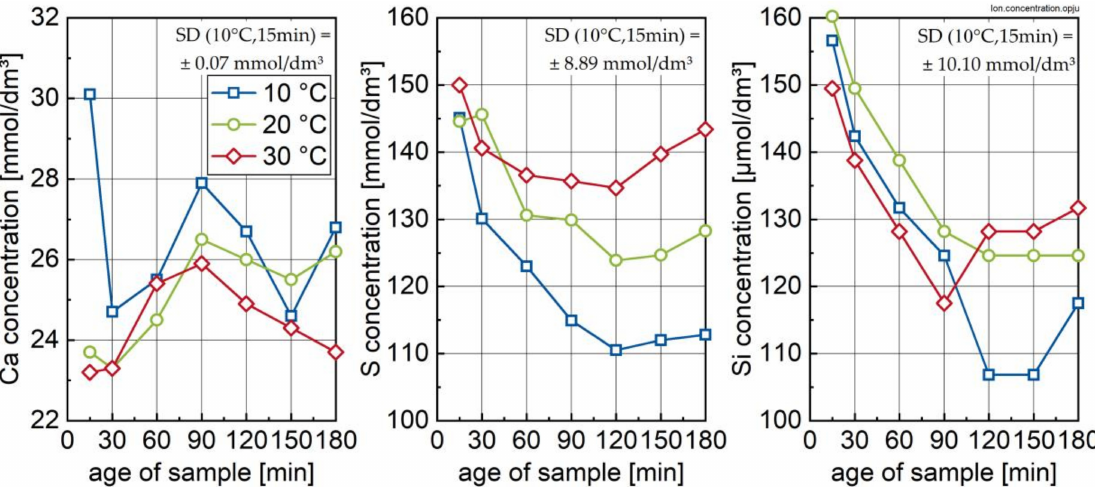
Figure 5. Concentration of the elements Ca ( left ), S ( middle ) and Si ( right ) in the aqueous phase as a function of time after water’s addition to the cement. Standard deviation (SD) calculated from two